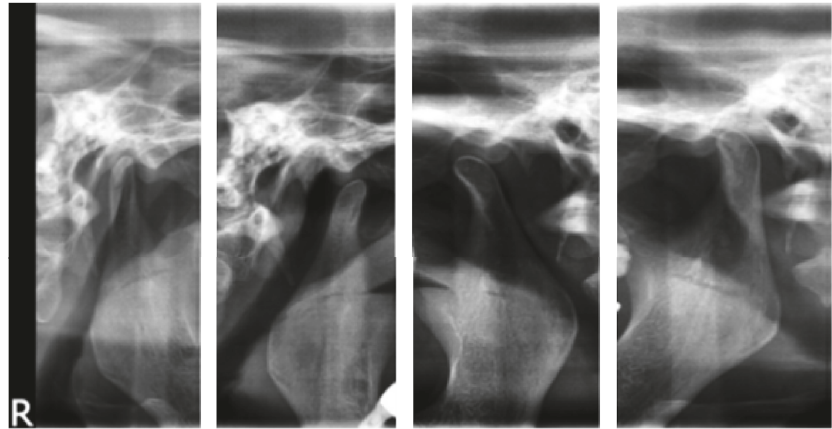
Figure 1: TMJ tomographic views which revealed an excessive anterior movement of the condyle on open mouth position.